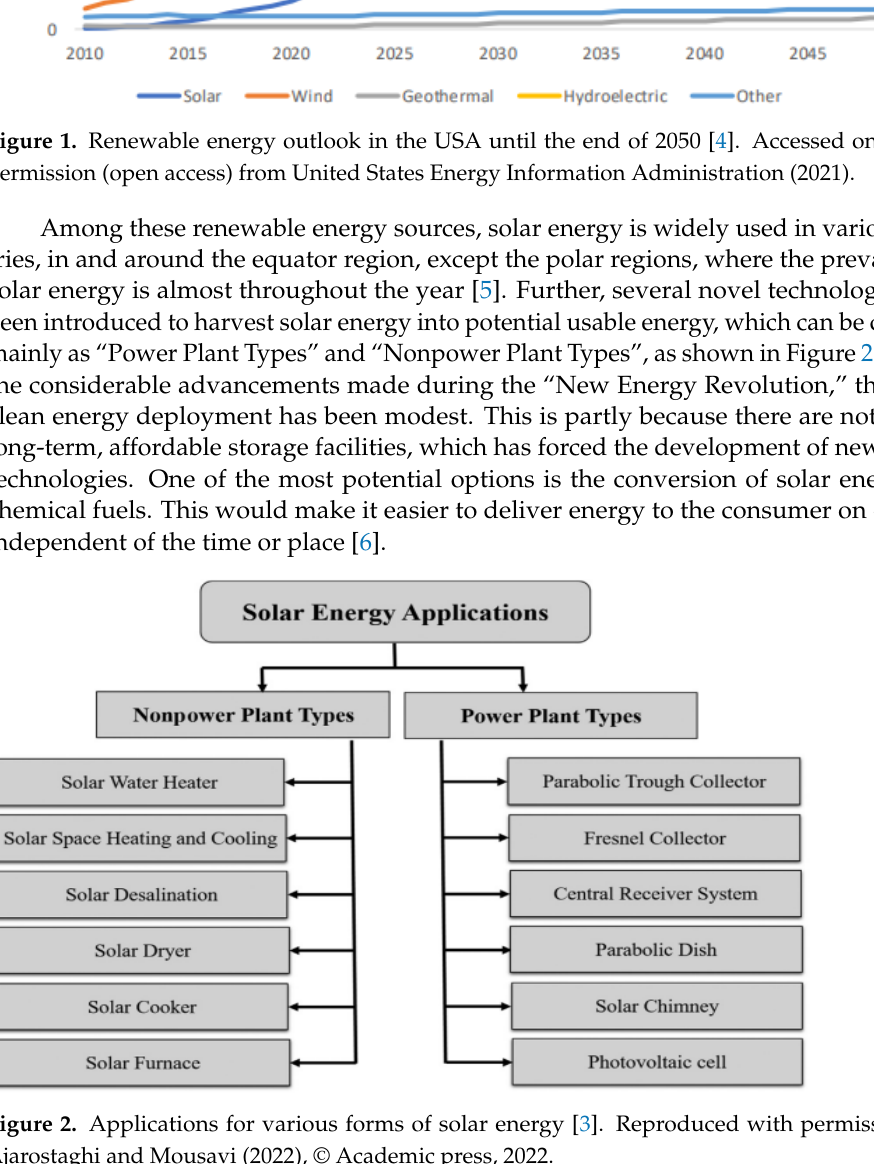
Figure 1. Renewable energy outlook in the USA until the end of 2050 [4]. Accessed online with per- mission (open access) from United States Energy Information Administration (2021).